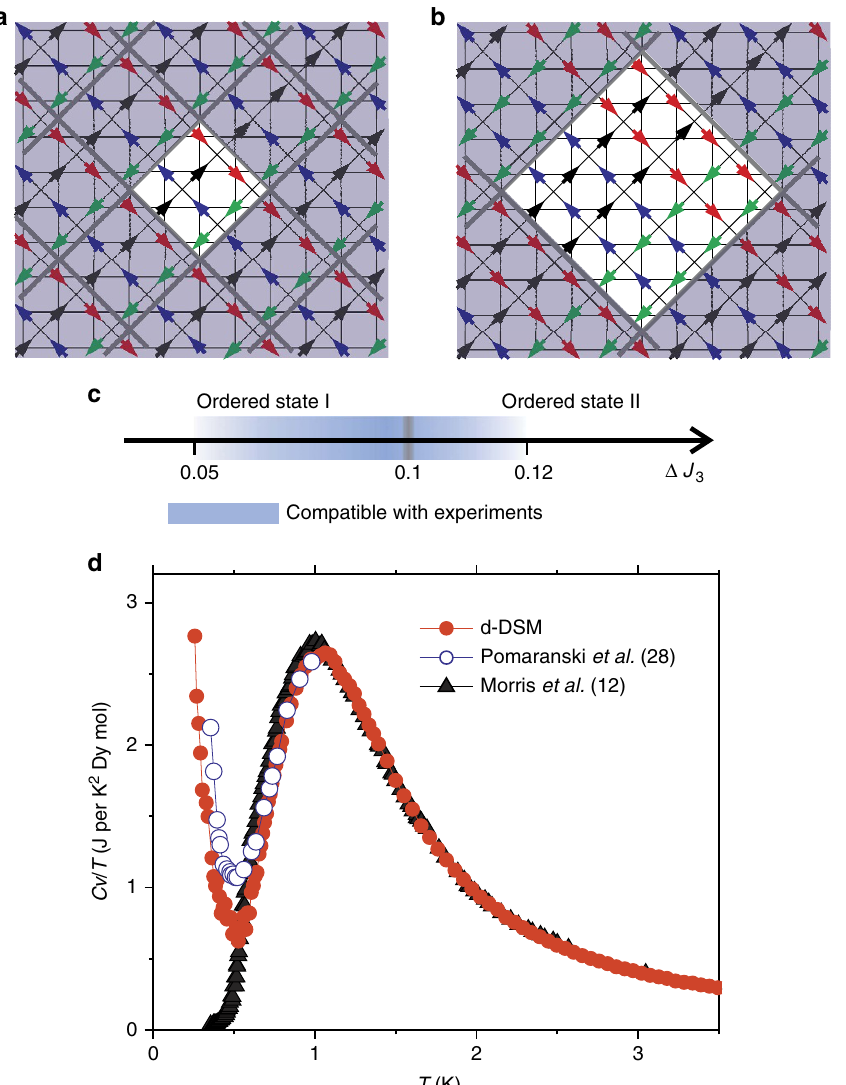
Figure 5 | Ordered states of the model with distortions (d-DSM). Within the range of parameters fixed by the experimental susceptibility data, and depending on the difference D J 3 between the third-nearest-neighbours exchange constant, the system orders into two possible states. ( a,b ) Cut along [100] of the two ordered states. The non-shaded regions correspond to the unit cells. ( c ) Ranges in D J 3 where each state is observed. ( d ) The signature of this transition in the specific heat divided by temperature, compared with the results obtained for DTO in refs 12,28